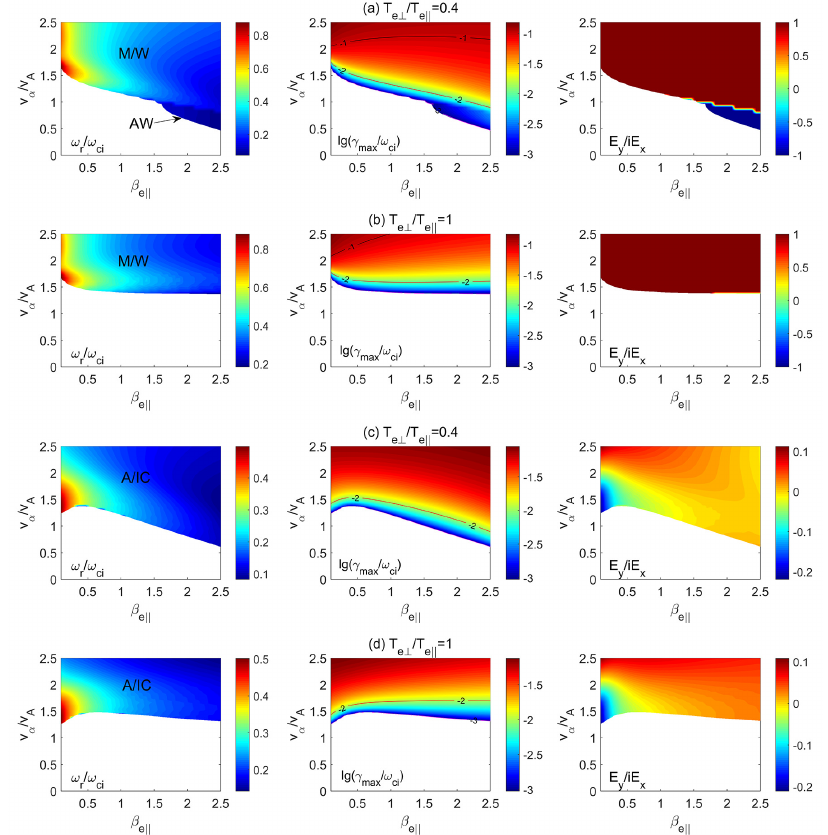
Figure 1. Color bar distributions of the real frequency ( ω r / ω ci ), maximum growth rate ( γ max / ω ci ), and polarization ( E y / iE x ) in the plane of the parallel electron beta ( β e (cid:107) ) and alpha beam drift velocity ( v α / v A ) for various electron temperature anisotropies and propagation angles: ( a ) T e ⊥ / T e (cid:107) = 0.4, θ = 0 ◦ ; ( b ) T e ⊥ / T e (cid:107) = 1, θ = 0 ◦ ; ( c ) T e ⊥ / T e (cid:107) = 0.4, θ = 50 ◦ ; ( d ) T e ⊥ / T e (cid:107) = 1, θ = 50 ◦